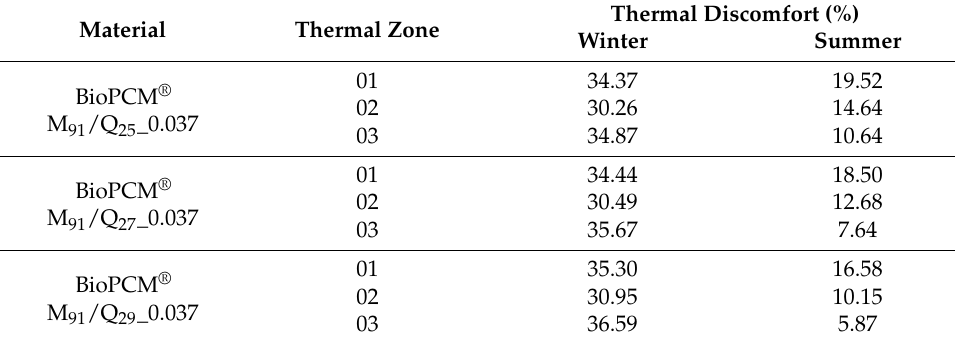
Table 9. Results obtained for PCM solutions with different melting point